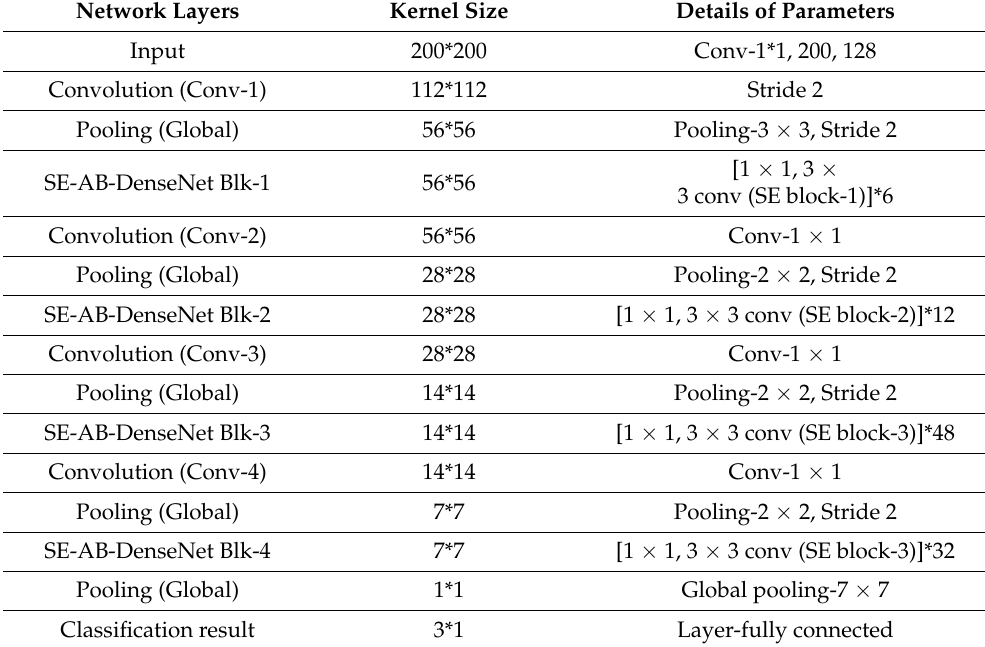
Table 1. Structure details of SE-AB-DenseNet network.